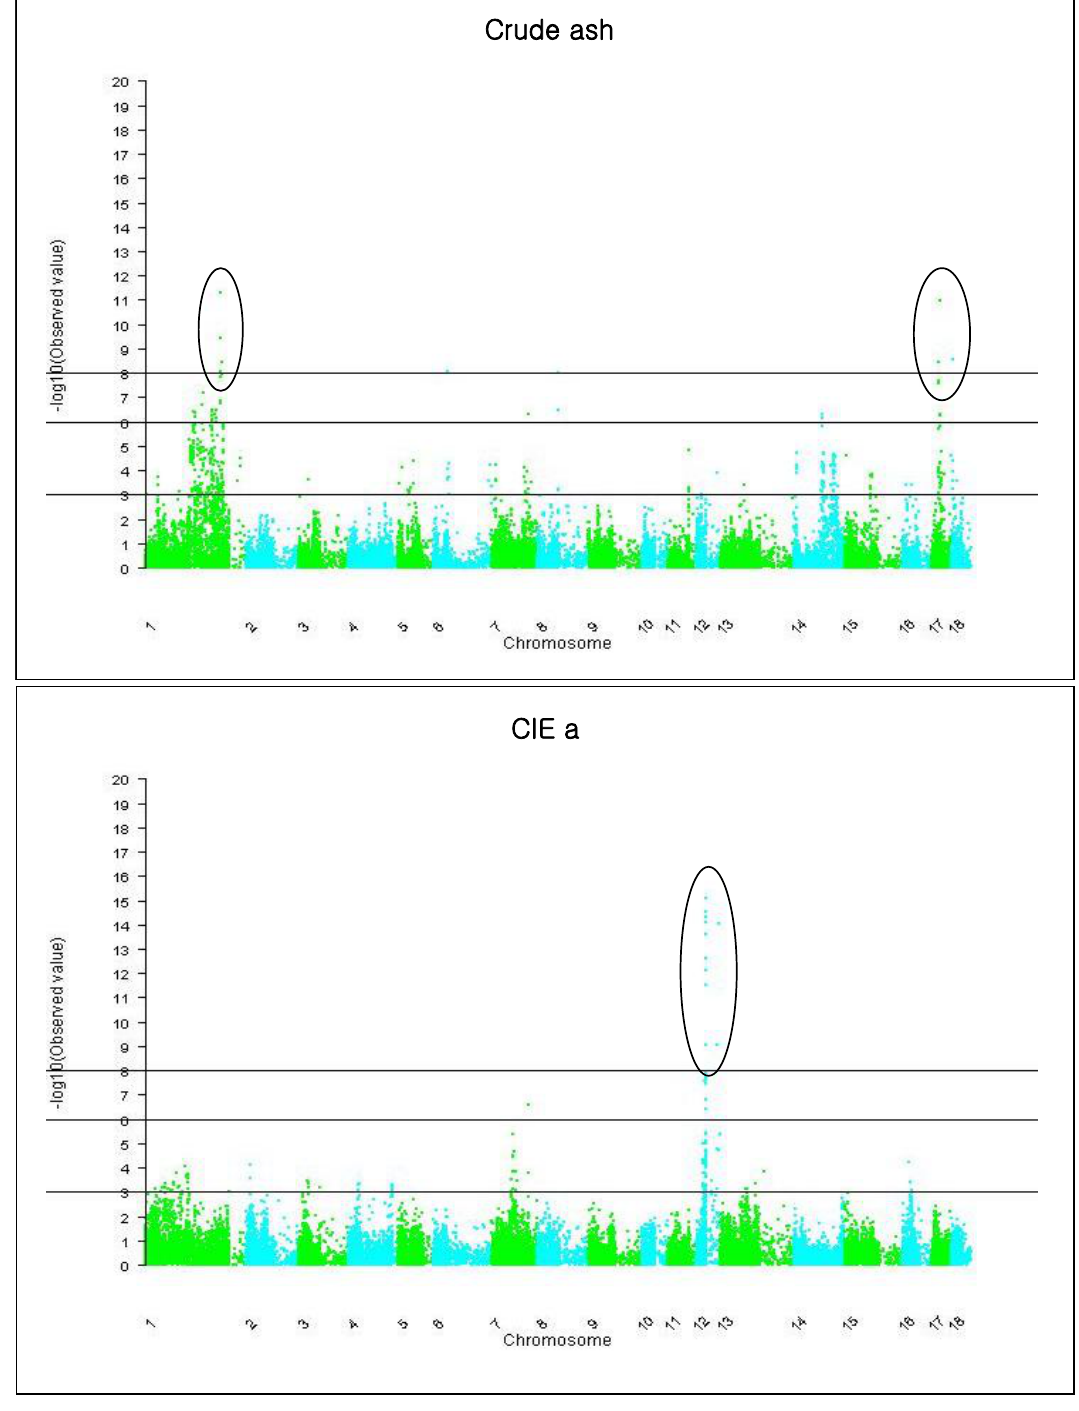
Figure 1. Test statistic profiles for crude protein, crude lipid, crude ash and Cie a under the additive and dominance model for each SNP. Circles indicate highly significant QTL (Continued). Y axis indicates -log 10 (p -value under the null hypothesis of no SNP